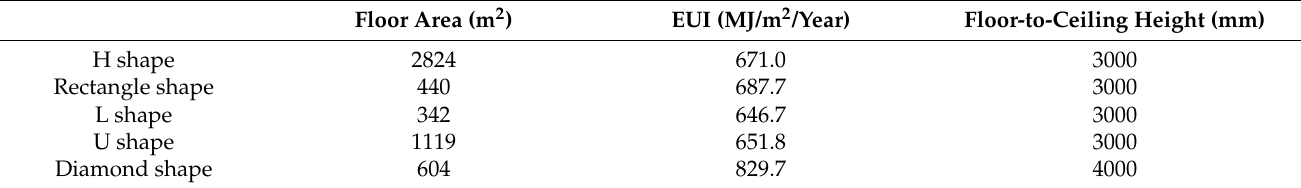
Table 12. Summary of case study building